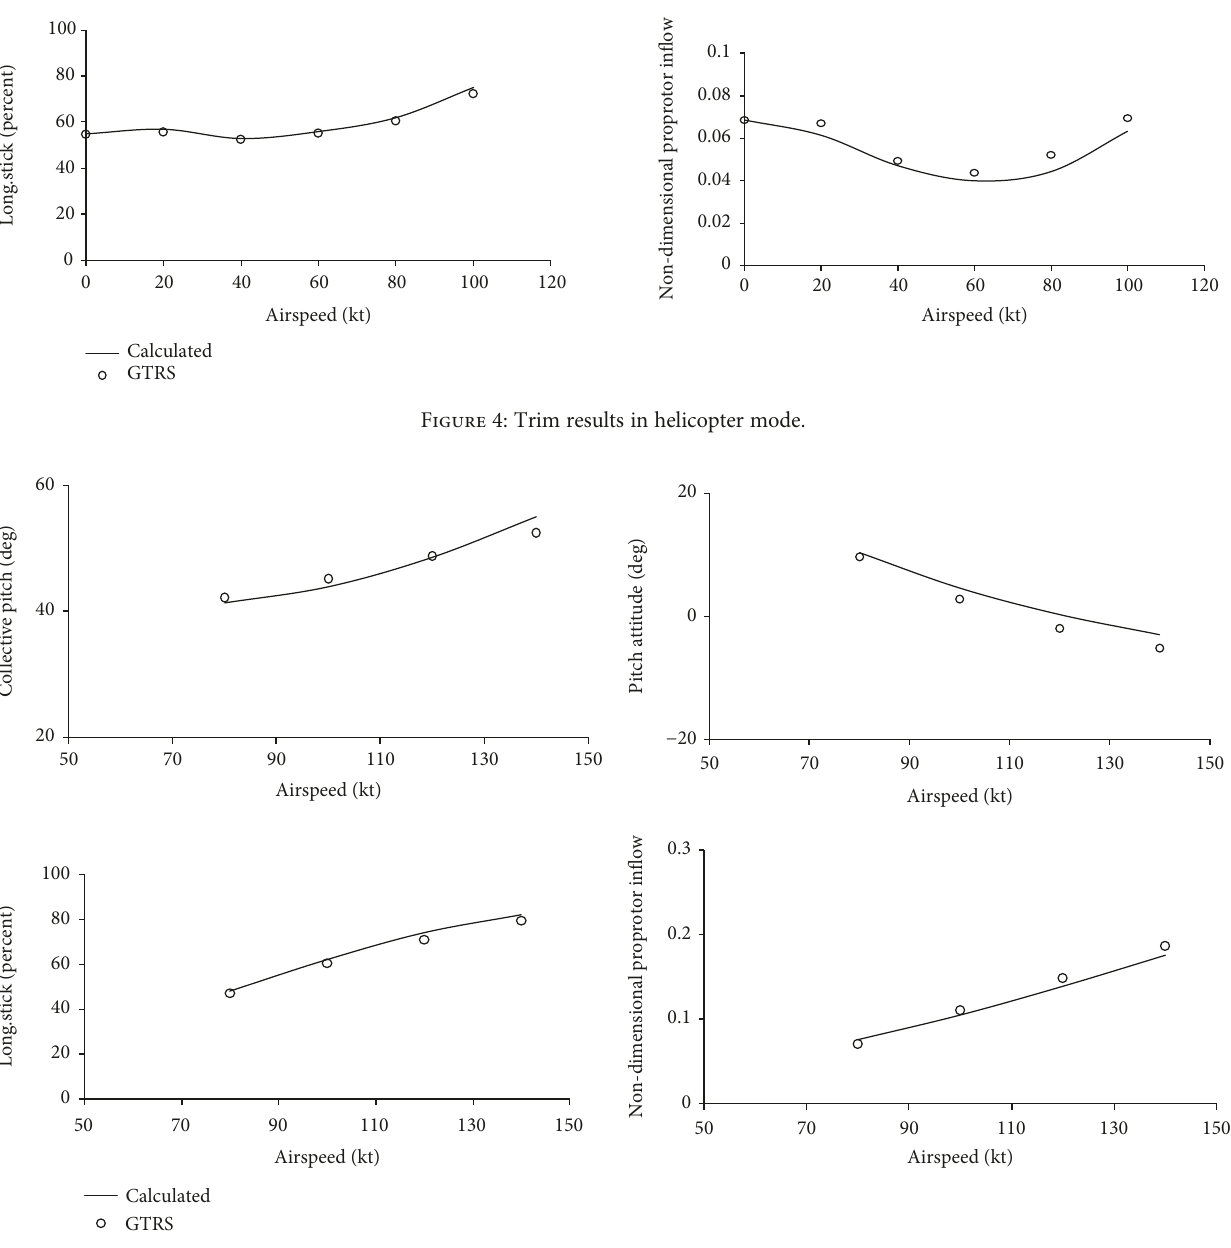
Figure 5: Trim results in nacelle 60